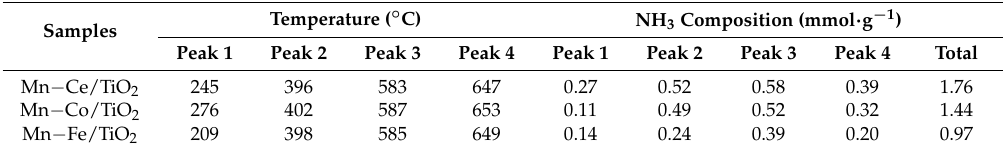
Table 4. Quantitative analysis of NH 3 -TPD